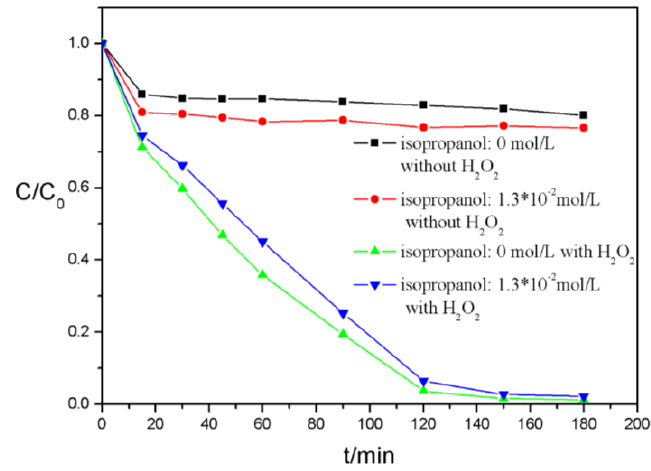
Figure 12. Effect of isopropanol on catalytic oxidation of AO7 [ C (AO7) = 5 × 10 −5 mol/L, C (H O ) = 4.85 × 10 −2 mol/L, C (CoTCPcNa-AN-CNFs) = 0.667 g/L, 25 2 2